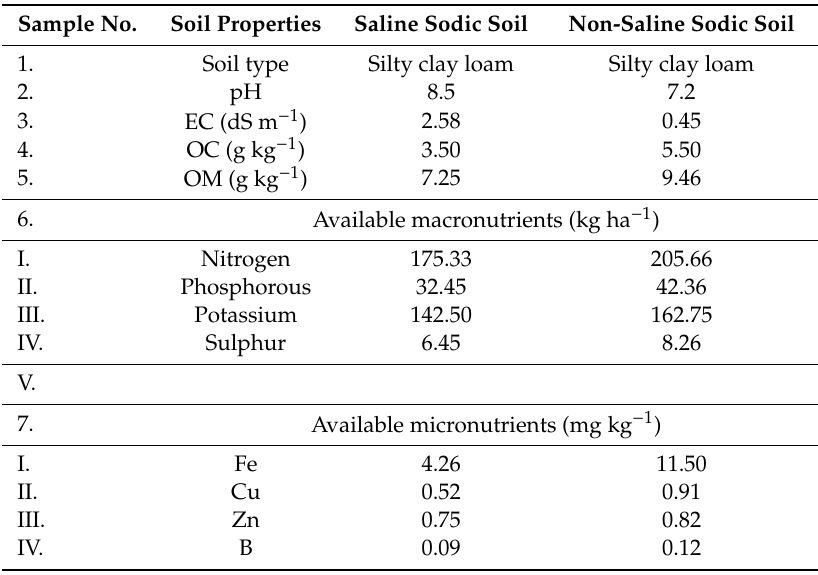
Table 1. Initial physico-biochemical properties of experimental soil.